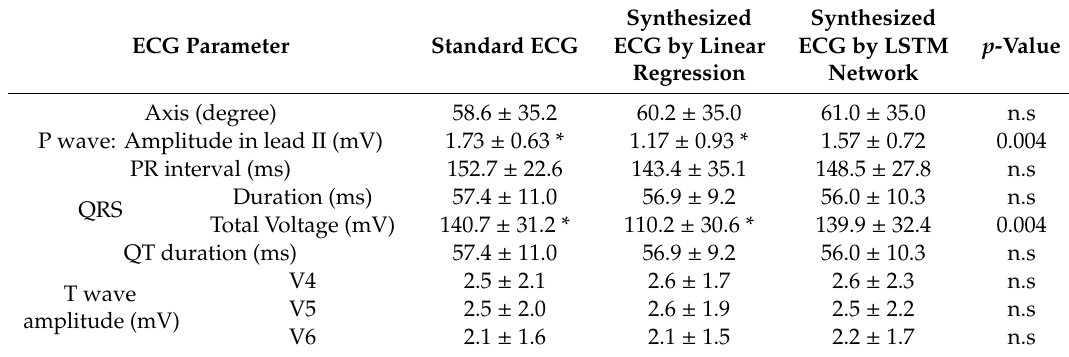
Table 2. CC and RMSE between standard 12-lead and reconstructed ECGs. ECG Parameter Standard ECG